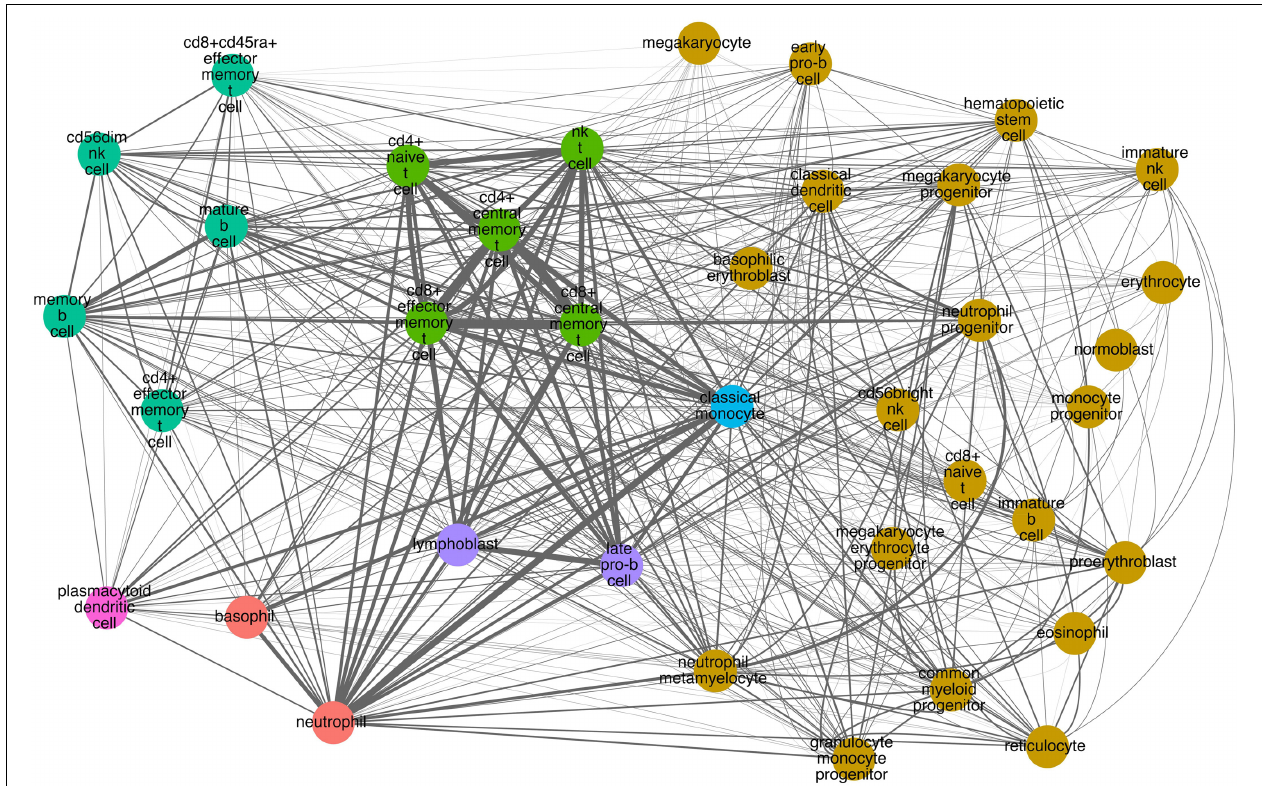
FIGURE 5 | CD molecule commonality graph on selected hematopoietic cells. Nodes correspond to cells. Colors correspond to the hierarchical clustering based on CD molecule expression ( Figure 4B ). Edges signify one